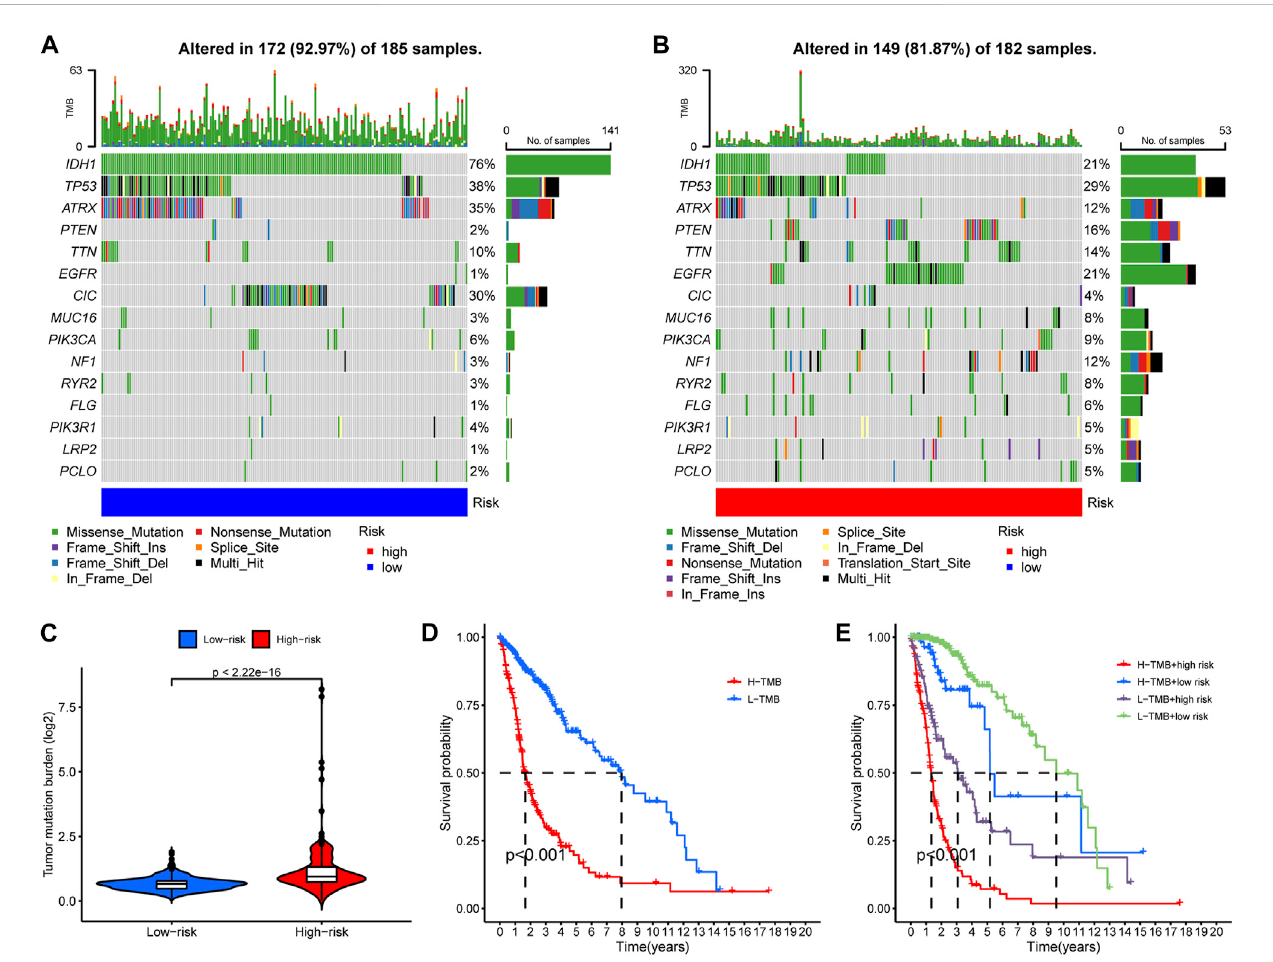
FIGURE 7 A general heavier tumor mutation burden (TMB) was observed in high-risk glioma samples and correlated with worse prognosis. (A – B) The occurrence frequency of the top 15 mutations in the high- and low-risk group glioma samples, respectively. (C) Overall TMB variation between the high- and